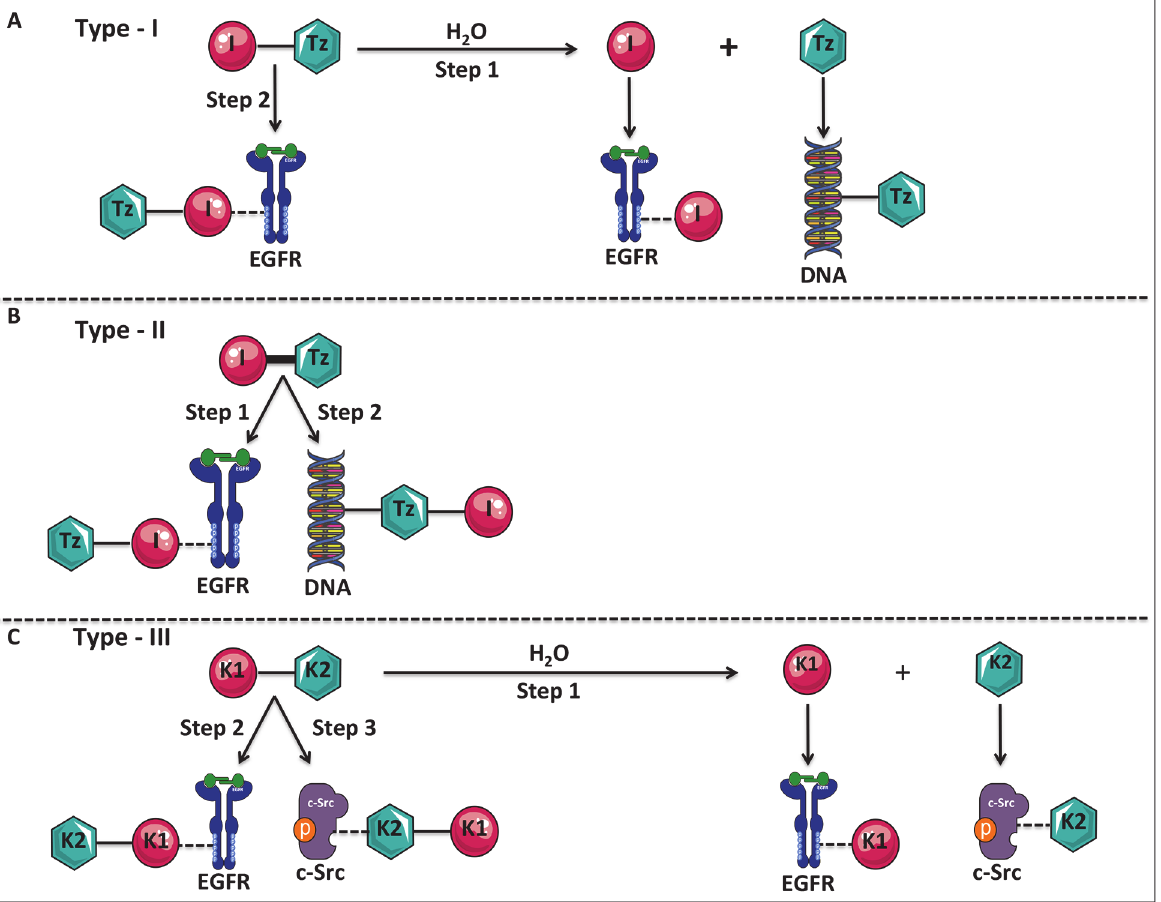
Fig 1. Prototypes of type-I, type-II and the novel type-III targeting molecules. ( A ) The type-I molecule (I-Tz) was designed to contain an EGFR tyrosine kinase inhibitor (I) and a DNA alkylating triazene (Tz) moiety bridged by a hydrolysable linker. The type-I molecule can inhibit EGFR as an intact structure (step 2), or upon undergoing hydrolysis to release the two moieties (I + Tz), but the molecule is only capable of targeting DNA through the release of its Tz moiety (step 1). ( B ) The type-II molecule was designed to contain the EGFR tyrosine kinase inhibitor (I) and the DNA alkylating triazene moiety (Tz) connected via a non-hydrolysable linker. This type-II molecule is capable of targeting both EGFR and DNA as an intact structure through each of its targeting arm (steps 1 and 2). ( C ) The novel type-III molecule (K1-K2) is designed to contain two tyrosine kinase inhibitors connected via a hydrolysable linker where K1 is targeted to Kin-1 (EGFR) and K2 to Kin-2 (c-Src). This molecule is “ programmed ” to exhibit both type-I and type-II like properties by inhibiting its two targets both as an intact structure (steps 2, 3) as well as upon undergoing hydrolysis to release inhibitors of EGFR and c-Src (step